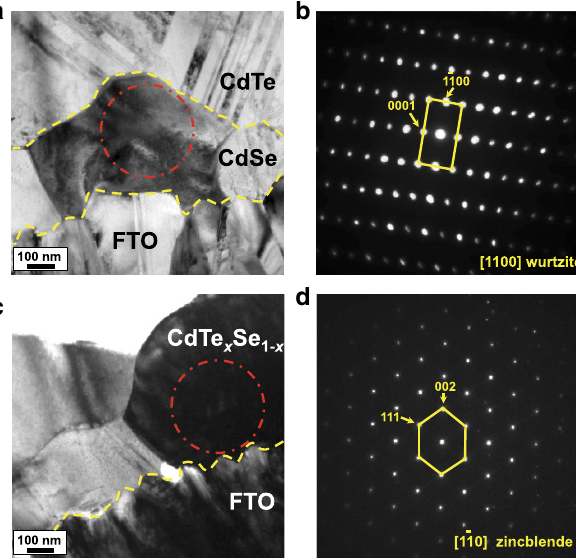
Figure 4 | CdTe growth-induced phase transformation. ( a – d ) BF-TEM images and SAD patterns of structures associated with the FTO/CdSe/ CdTe interfaces. The yellow-dashed lines designate the FTO, CdSe and CdTe interfaces for each sample. ( a ) BF-TEM image of the FTO/CdSe/CdTe structure for the cell with a 400nm-thick CdSe layer. ( b ) TEM-SAD pattern acquired from the grain region outlined with a red dashed circle in a . The SAD pattern is indexed as [1100] for the CdSe wurtzite phase. ( c ) BF-TEM image of the FTO/CdTe x Se 1 (cid:2) x region for the cell with a 100nm-thick CdSe layer. ( d ) TEM-SAD pattern acquired from the grain region outlined with a red dashed circle in c . The SAD pattern is indexed as ½ 110 (cid:3) for the CdTe x Se 1 (cid:2) x zincblende